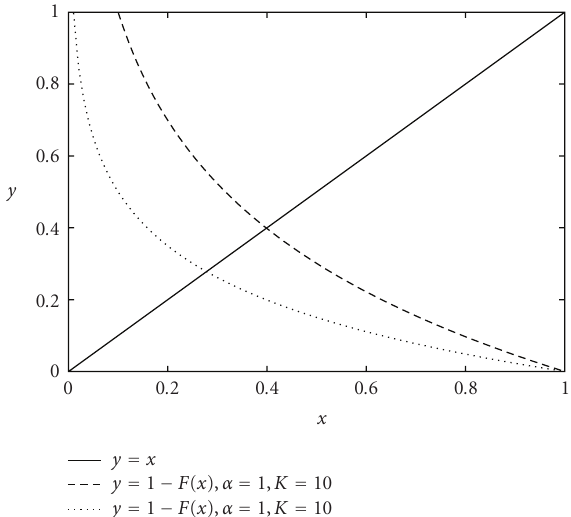
Figure 1: Complementary distribution function F ( x ) = 1 − F ( x